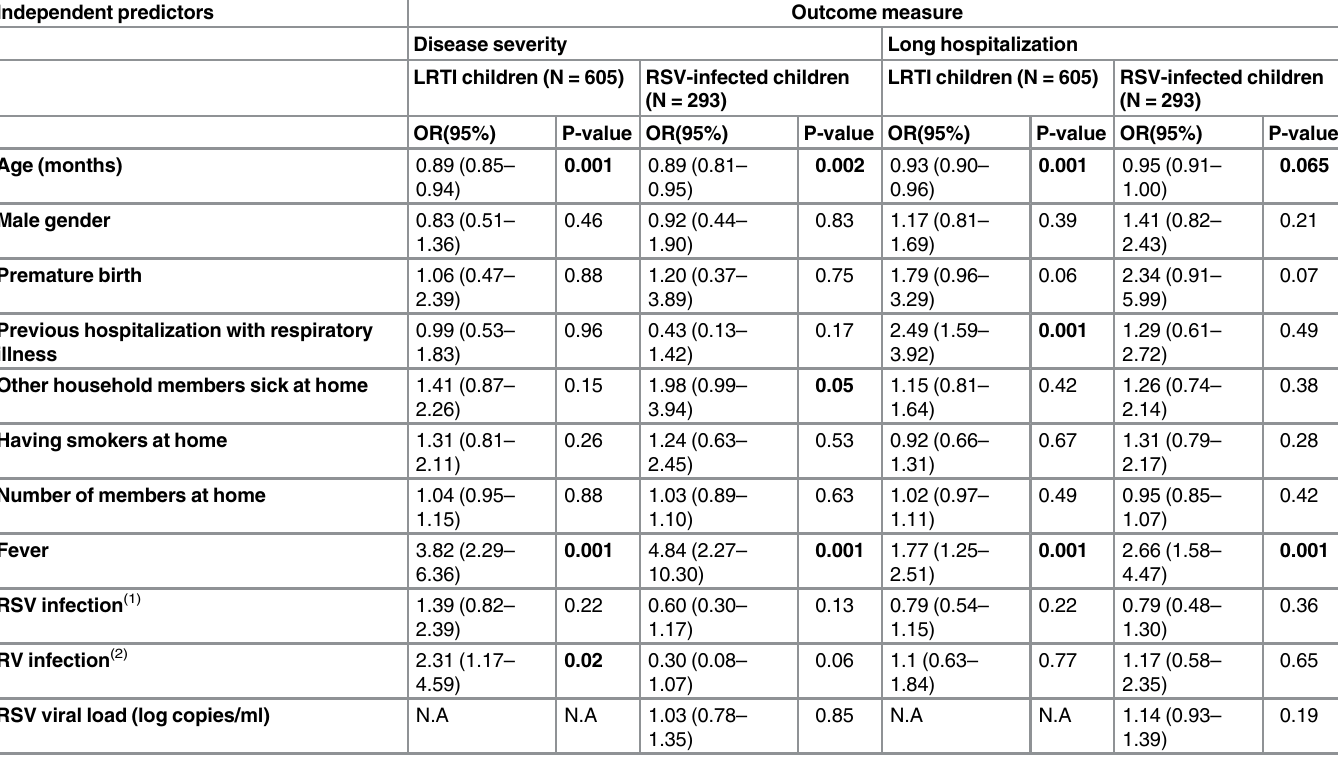
(1) RSV single infection factor was used for the model of the whole population and RSV subgroup (RSV B versus A) was used for the model of RSV-infected patients (2) RV single infection factor for the model of the whole population and RV co-infection with RSV for the model of RSV-infected